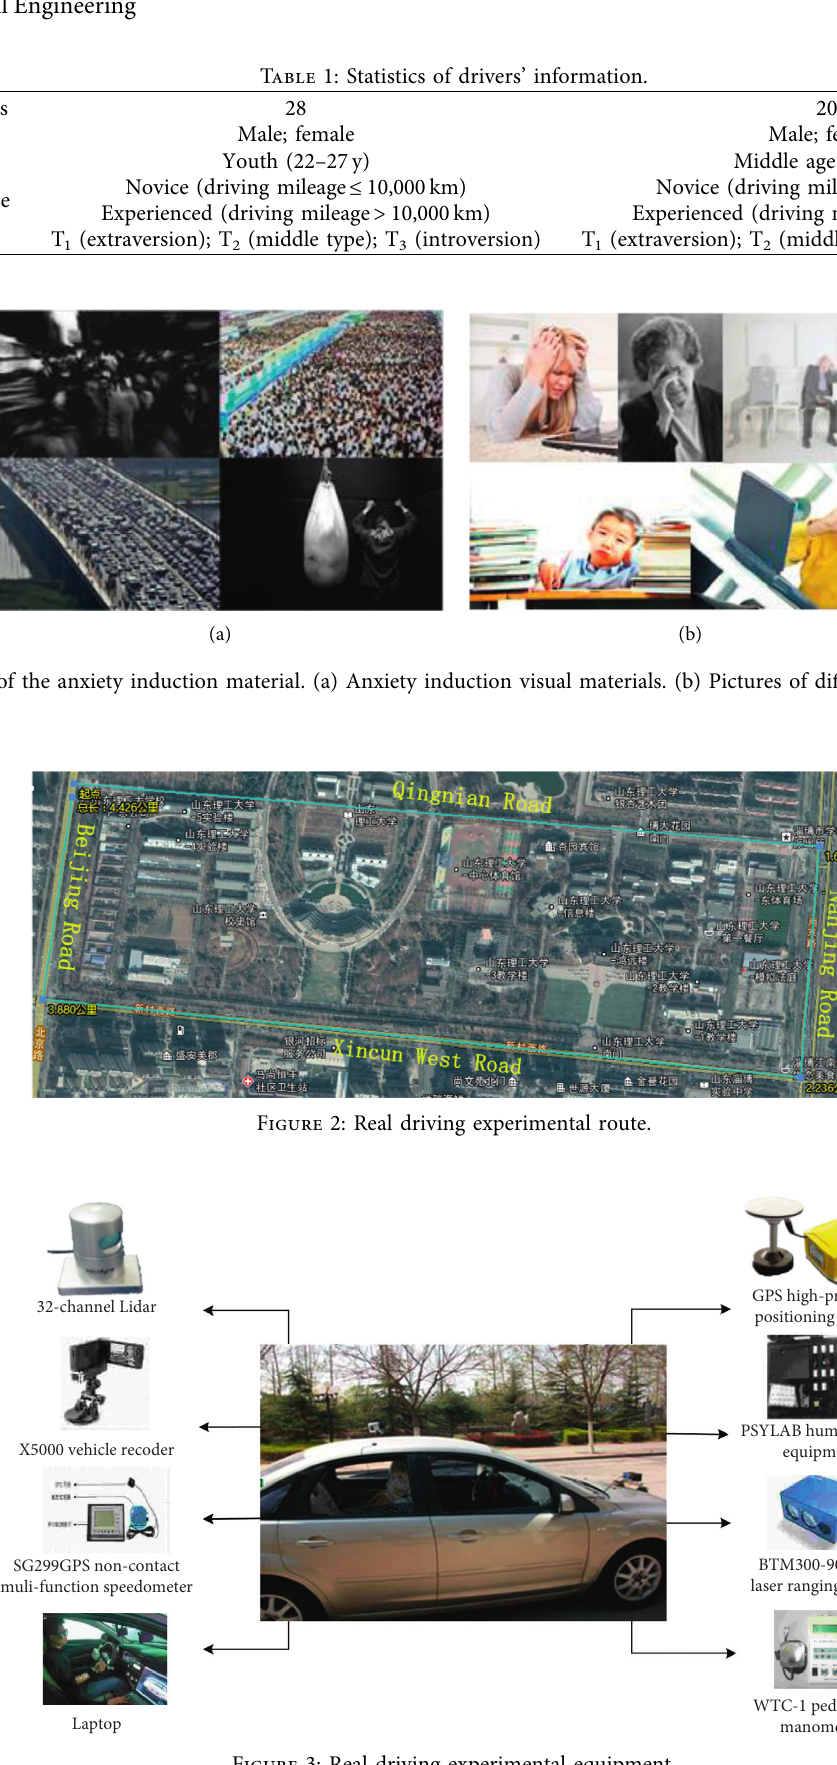
Figure 3: Real driving experimental